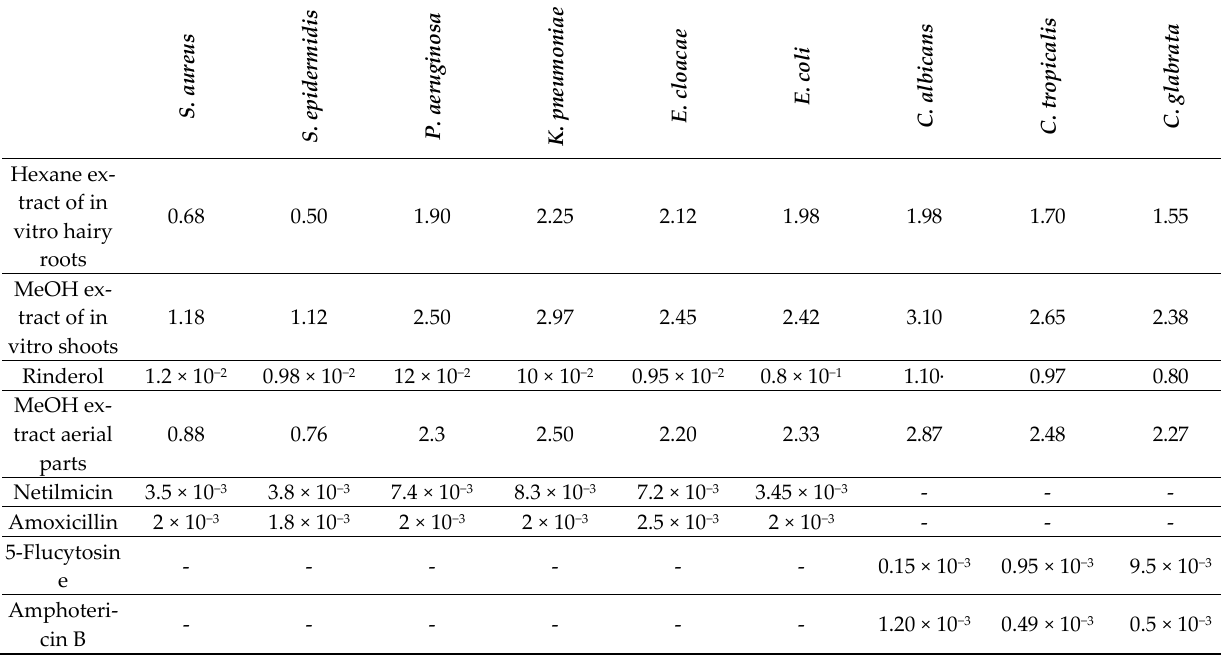
Table 3. Results of antimicrobial activities (minimum inhibitory concentration (MIC) values) of all tested extracts and pure metabolites ( μ